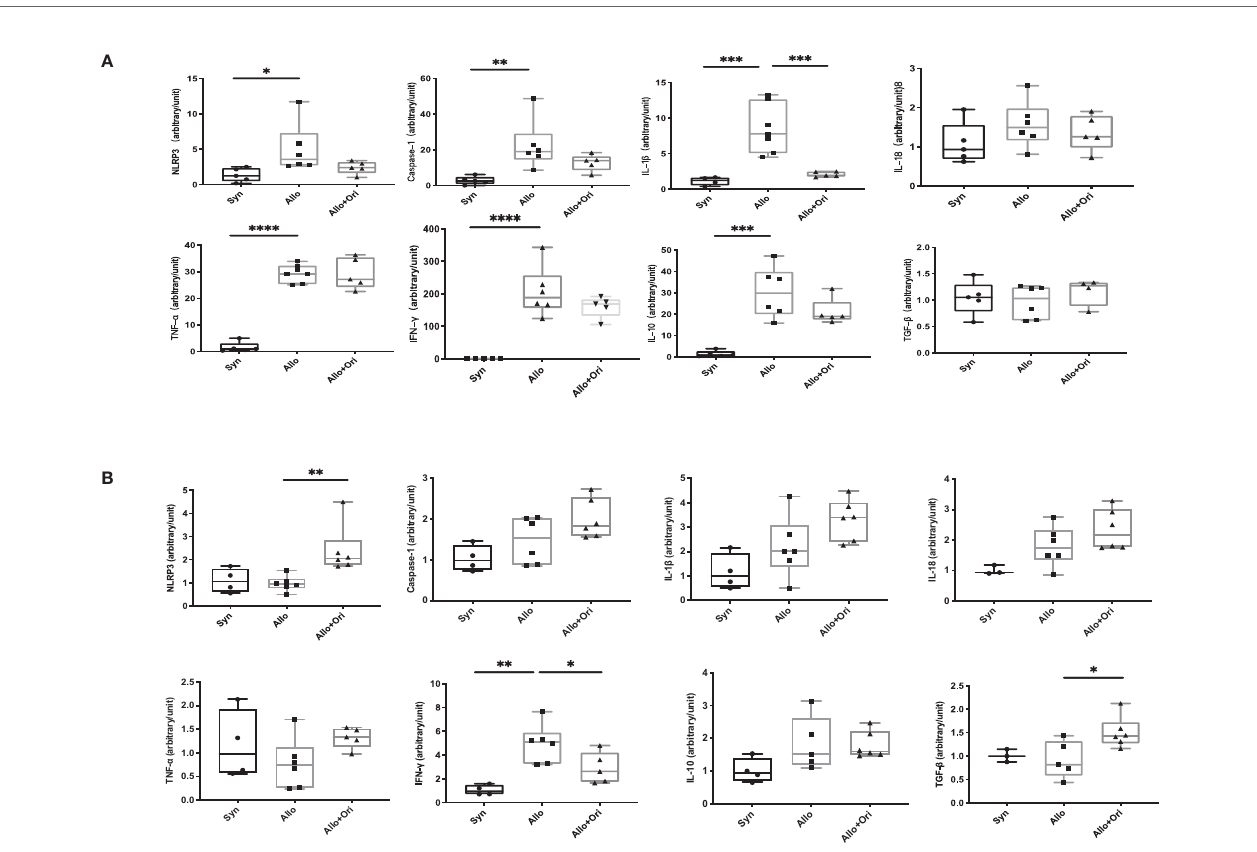
FIGURE 4 | The quantitative changes of mRNA expression in cardiac graft and SPCs following Ori treatment. Cardiac grafts and spleens were harvested on POD7 from syngeneic (Syn), allogenic (Allo), and Ori-treated (Allo + Ori) groups. The total mRNA was extracted from cardiac grafts (A) and SPCs (B) , and the mRNA expressions of NLRP3, Caspase-1, IL-1 b , IL-18, TNF- a , IFN- g , IL-10, and TGF- b were measured by qRT-PCR. Values are shown as the mean ± SD; * p < 0.05, ** p < 0.01, *** p < 0.001, **** p <